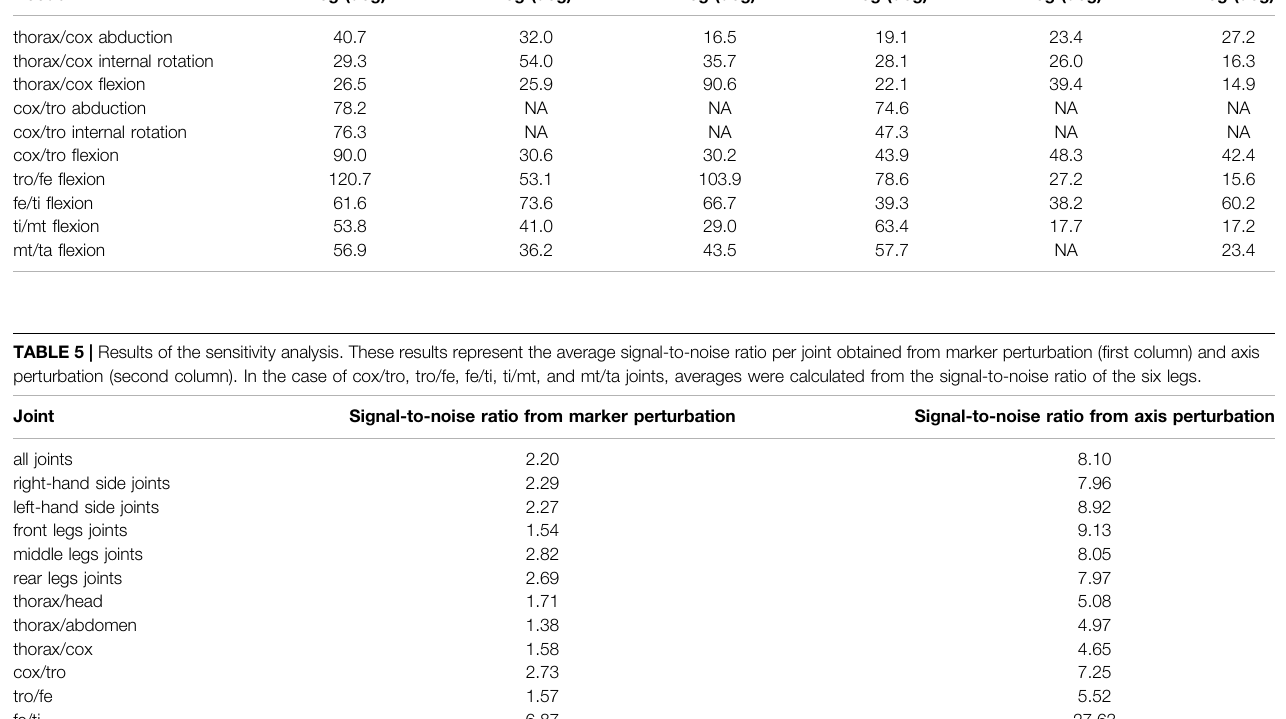
TABLE 4 | Results of the inverse kinematic simulation for the leg joints. Reported values represent the range of motion in degrees of the joint angles. Non-allocated values (NA) correspond to blocked degrees of freedom. degree of freedom